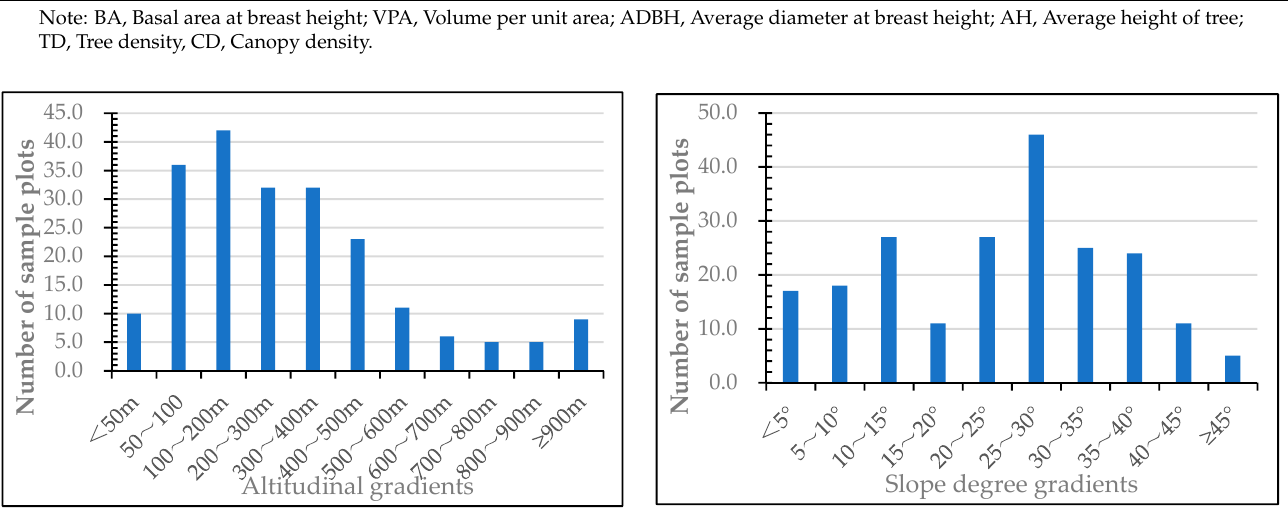
Figure 2. Variation characteristics of plot quantity with altitude gradients and slope gradients. Table 6. The ANOVA and multiple comparison of vegetation carbon density (mean ± SE) in different layers among stand